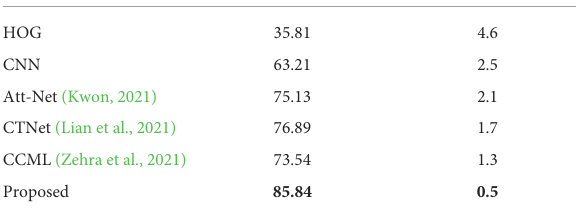
TABLE 2 Comparison between different methods and feature fusion methods in this